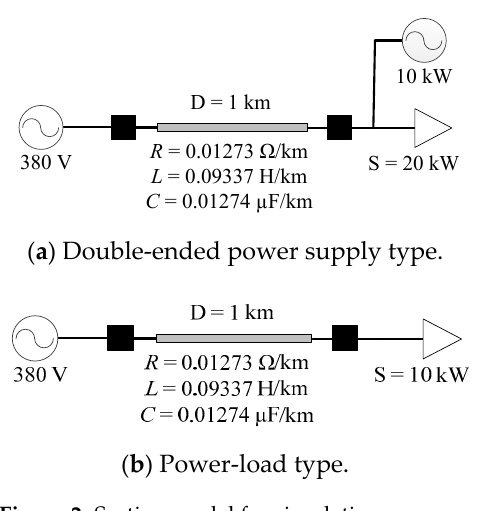
Figure 2. Section model for simulation.